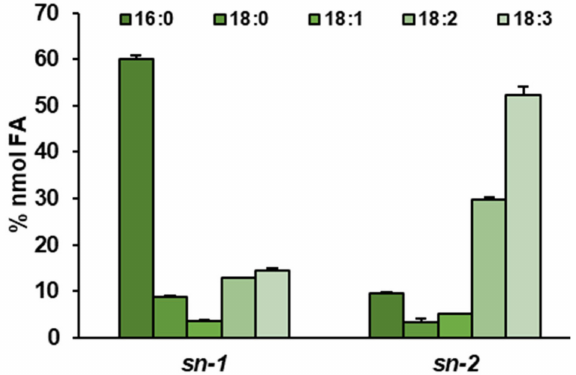
Figure 3. Fatty acids composition of sn-1 and sn-2 position in phosphatidylethanolamine isolated from C. sativa in vivo leaves. Error bars indicate the SD between the three biological repeats ( n =